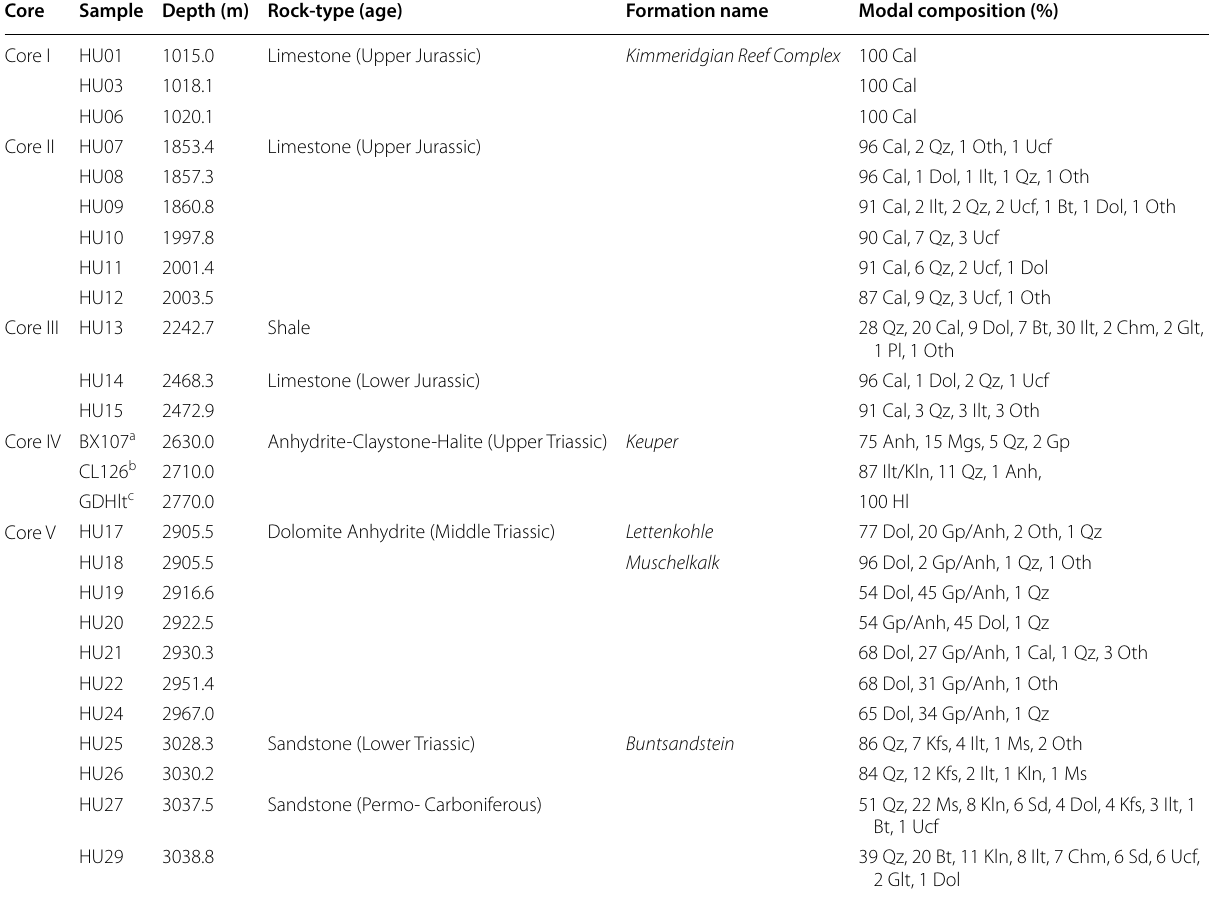
Data for Core IV were not sampled in Humilly but derive from literature accordingly to references a, b and c. Mineral abbreviations are after Whitney and Evans (2010): Bt Biotite, Cal Calcite, Chm Chamosite, Dol Dolomite, Glt Glauconite, Gp/Anh Gypsum/Anhydrite, Hl Halite, Ilt Illite, Kln Kaolinite, Kfs K-Feldspar, Mgs Magnesite, Ms Muscovite, Oth Other, Pl Plagioclase, Qz Quartz, Sd Siderite Ucf unclassified a After Müller and Briegel (1977) b After Freund (1992) c After Yan et al.